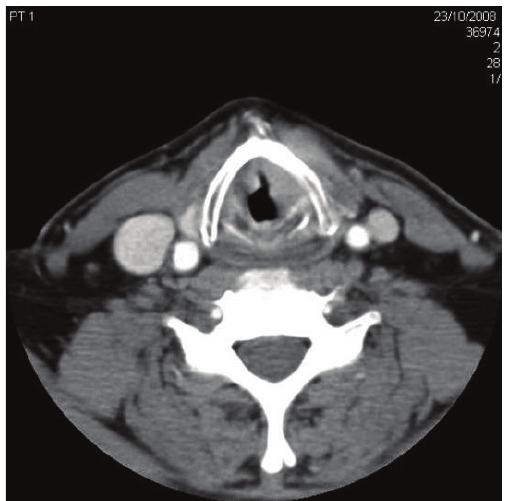
Figure 1: CT neck showing mass.